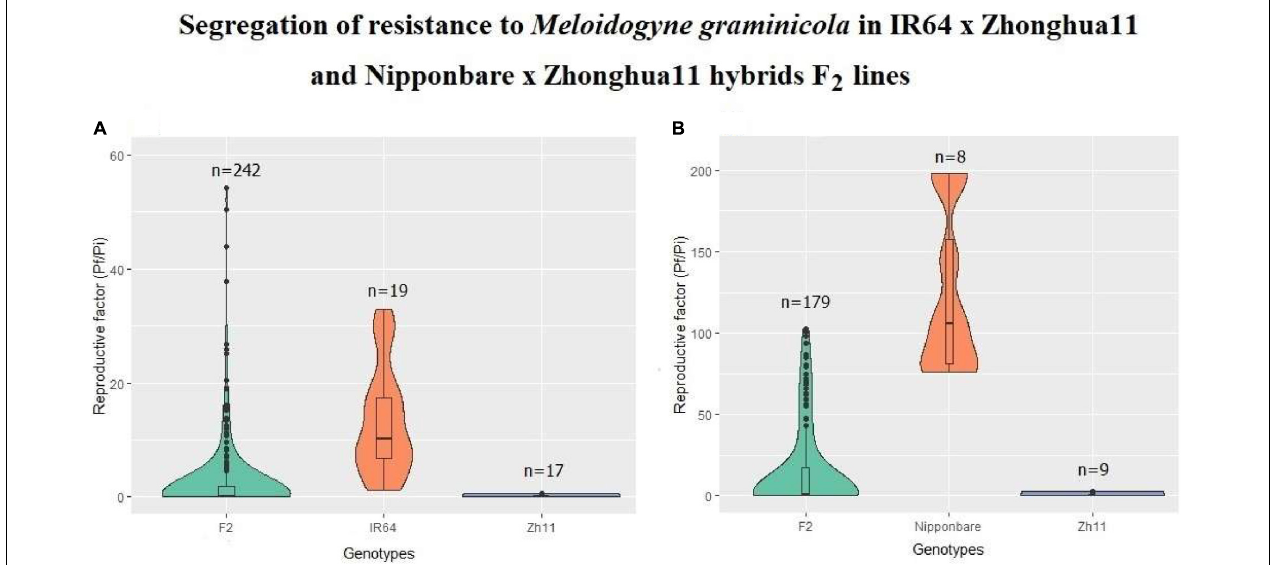
FIGURE 1 | Reproduction factor of Meloidogyne graminicola on rice. Segregation of resistance observed in F 2 progenies from crosses (A) IR64 × Zh11 and (B) Nipponbare × Zh11, compared to resistance level in Zhonghua 11 or susceptibility in susceptible parents, IR64 and Nipponbare, respectively. Reproduction factors (Pf/Pi) represents for each plant the number of nematodes recovered from roots (Pf) 30 days after inoculation of 100 M. graminicola stage 2 infective juveniles